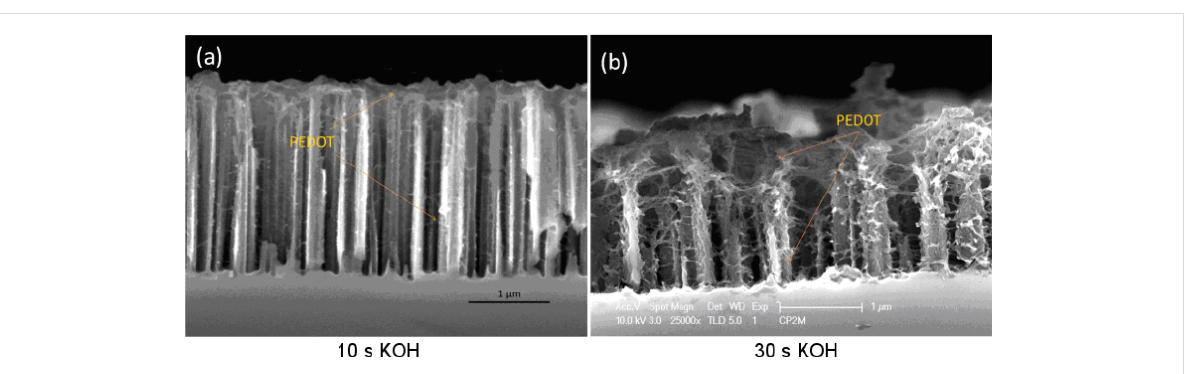
Figure 11: Cross-sectional view of HRSEM images of SiNWs/PEDOT sample after 10 s tapering (a) and 30 s tapering